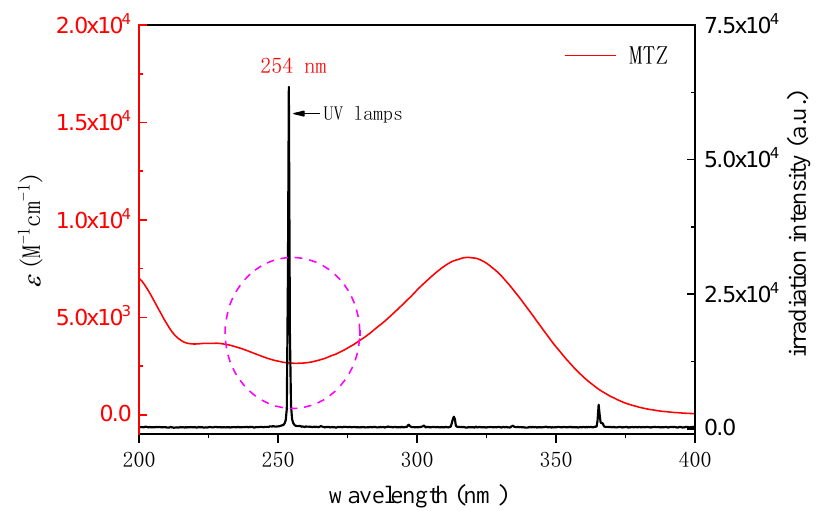
Figure 4. Decadic molar absorption coefficient ( ε ) of MTZ with reference to the UV lamp emission spectra from 200 to 400 nm.